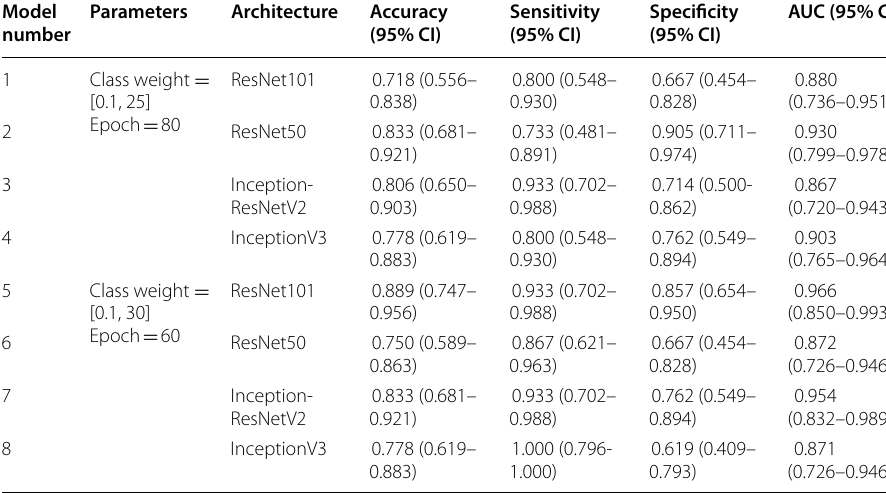
CI confidence interval, AUC area under curve